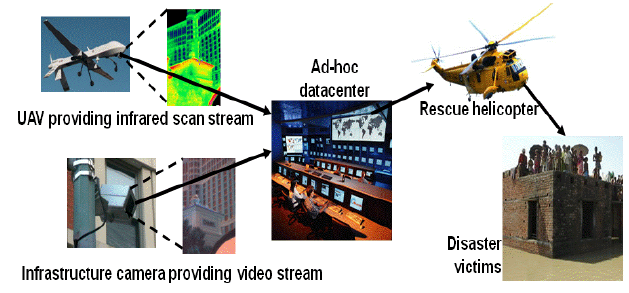
Fig. 1: Search and Rescue Motivating